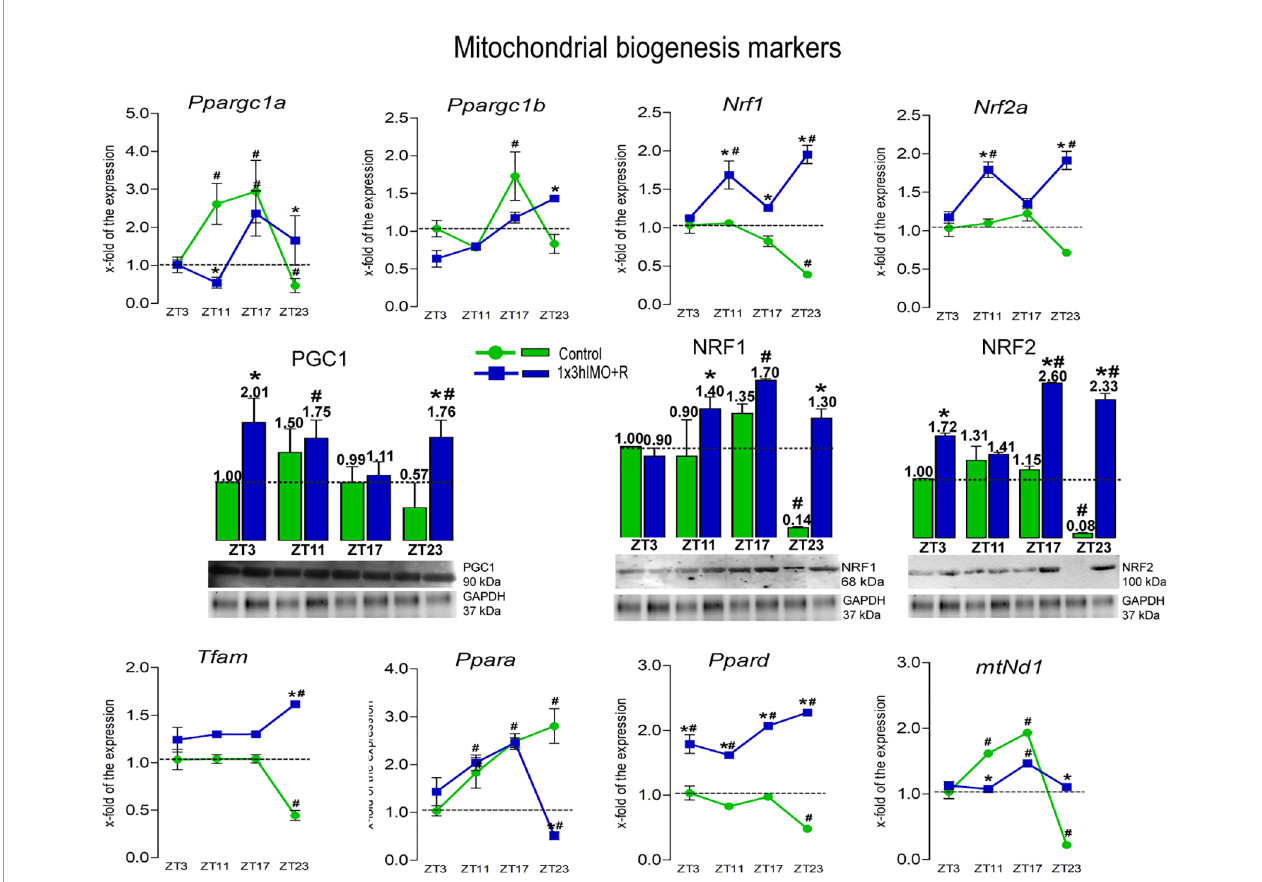
FIGURE 3 | Transcription of mitochondrial biogenesis markers is signi fi cantly changed in spermatozoa of acutely stressed adult rats in a time-dependent manner. Isolated RNA and proteins from spermatozoa of undisturbed and stressed rats were used for the analysis of the transcriptional pro fi le and protein expression pro fi le of markers of mitochondrial biogenesis. The representative blots are shown as panels. Data from scanning densitometry were normalized on GAPDH (internal control). Values are shown as bars above the photos of blots. Data are presented as green dots connected with a green line for the control group, and blue squares connected with a blue line for the 1x3hIMO group, and are mean ± SEM values of two independent in vivo experiments. Statistical signi fi cance was set at p < 0.05: * vs. the control group of the same time point, # vs. the control group of ZT3 time